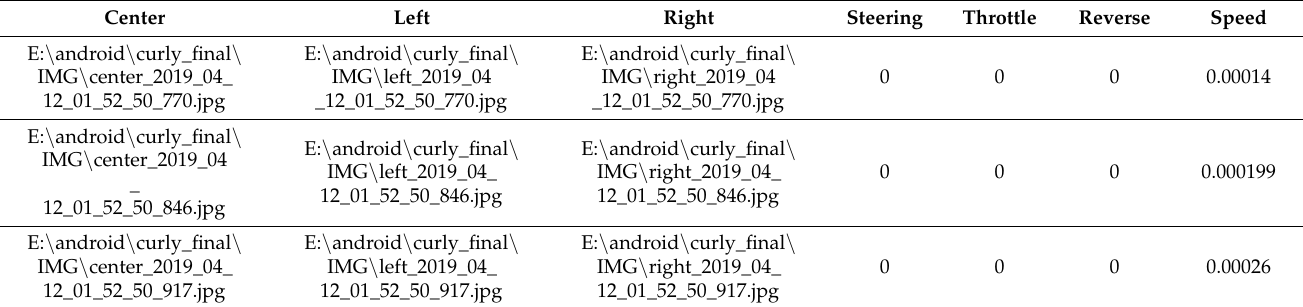
Table 1. Recorded data at training mode.